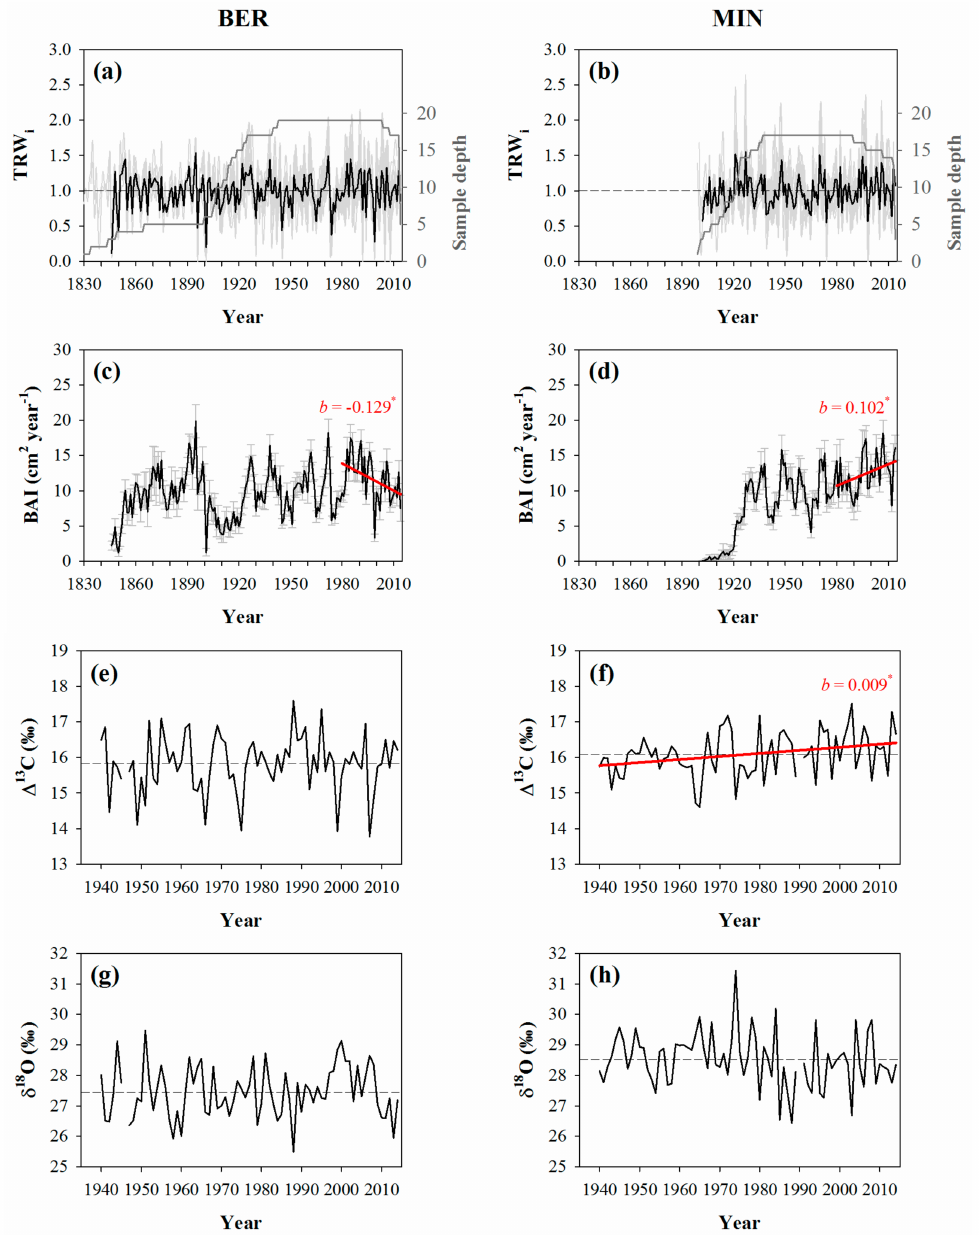
Figure 2. Tree-ring chronologies for BER (left panels) and MIN (right panels). ( a , b ) Residual tree-ring width indices (TRW i ) (grey lines) and master chronologies (black lines) for the period when expressed population signal (EPS) exceeded 0.85 (see Table 1). The sampling size for each chronology is indicated by a dark grey line. ( c , d ) Mean basal area increment (BAI) calculated from the set of raw TRW series. Error bars denote standard errors. ( e , f ) Carbon isotope discrimination ( ∆ 13 C) and ( g , h ) oxygen isotope composition ( δ 18 O) for the period 1940–2014. Dashed horizontal lines correspond to mean values of tree-ring traits (except BAI). Significant linear trends over time are depicted as red lines (* p < 0.05), with the corresponding slope ( b ) of the trend indicated in each